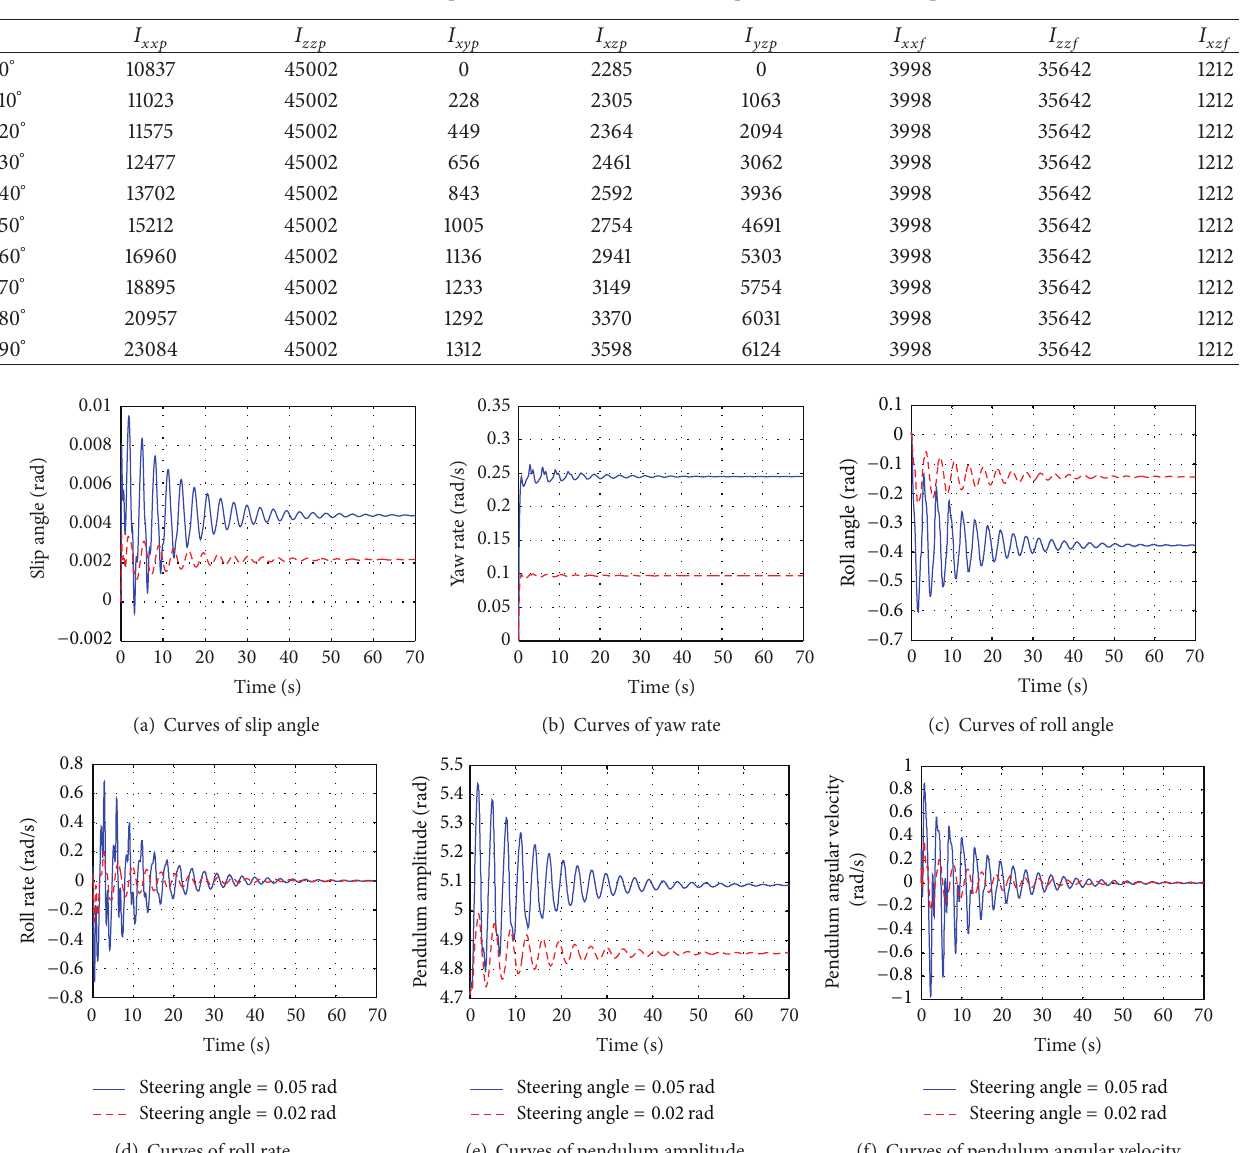
Table 2: The inertia tensors of the pendulum mass and the fixed liquid mass when the liquid fill level is 0.5.